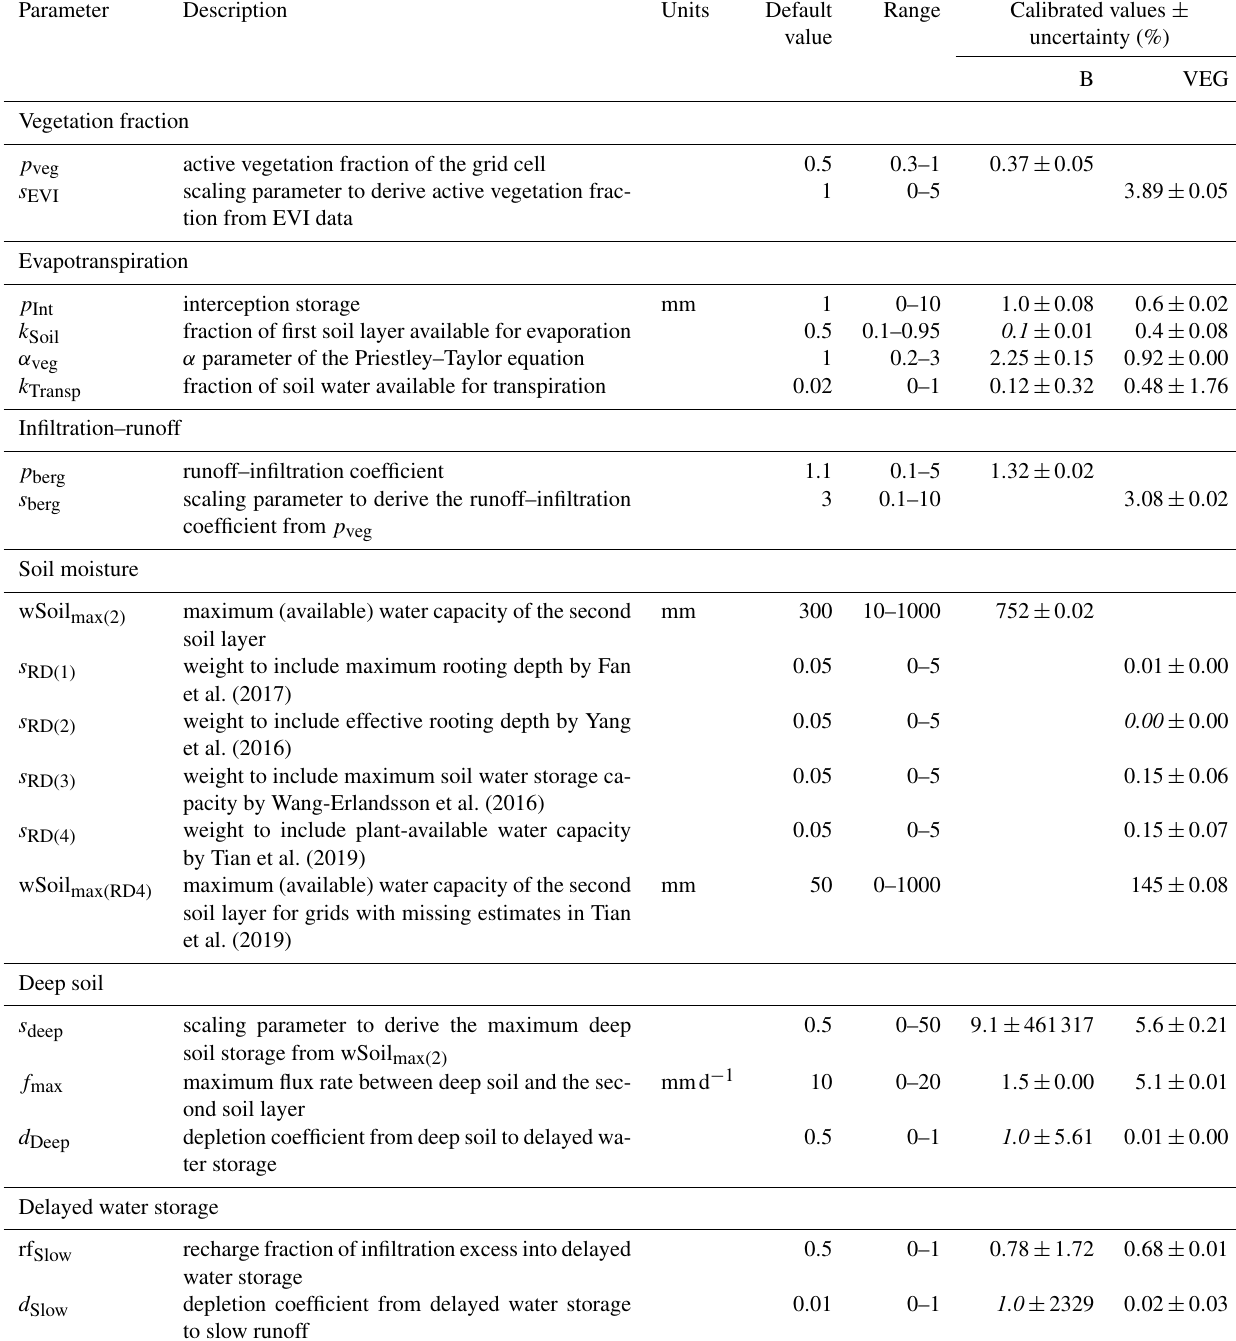
Table 2. Calibrated model parameters and their description, range, and calibrated values for experiments B and VEG. Text in italics highlights calibrated values at the predefined parameter